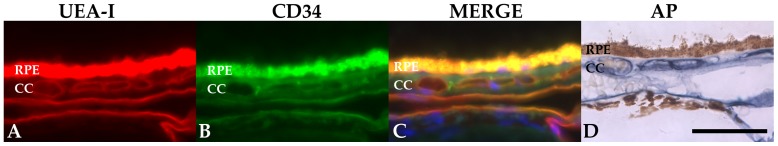
Tandem triple labeling of CD34/UEA-I and endogenous alkaline phosphatase.Following epifluorescence photomicrography (A, B,C), coverslips were removed and sections reacted with NBT/BCIP. Note the good correspondence between alkaline phosphatase activity (D) and UEA-I binding (A) that includes capillaries that do not react with CD34 antibody (B). CC, choriocapillaris; scalebar = 50 µm.